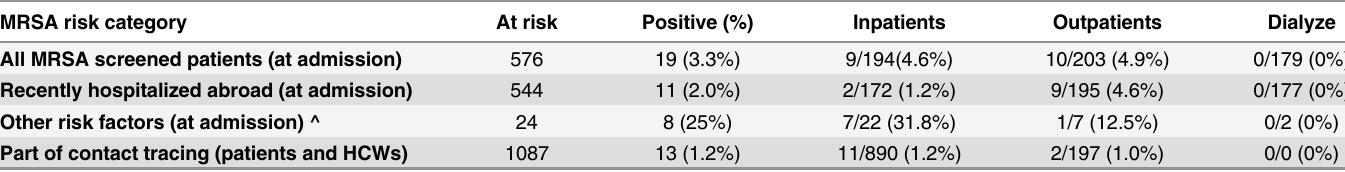
Table 3. MRSA prevalence in risk groups between 2008 –